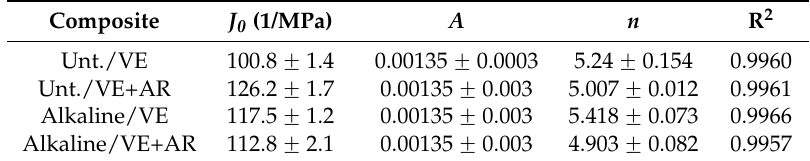
Table 5. Parameters in Findley Power Law equation for different composites under